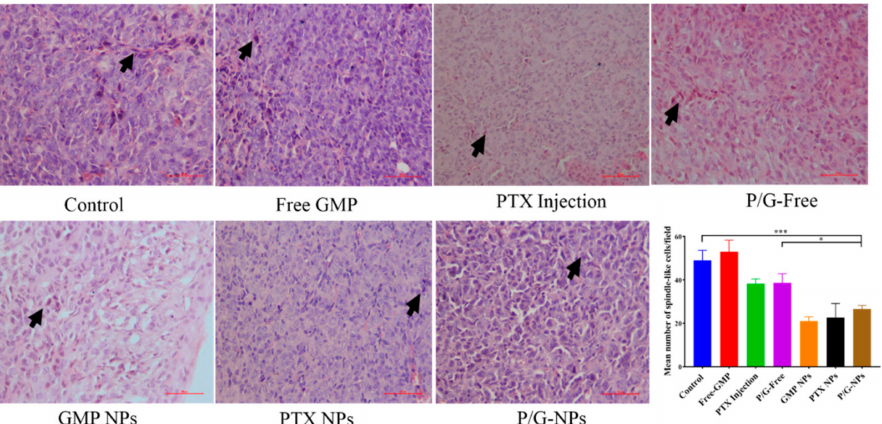
Figure 7. H&E stain of tumor tissue under different treatments, showing the presence of spindle-shaped cells (arrow) (200 × ), and the quantitative results of the mean number of spindle-like cells/field, *** p < 0.0005, * p < 0.05.